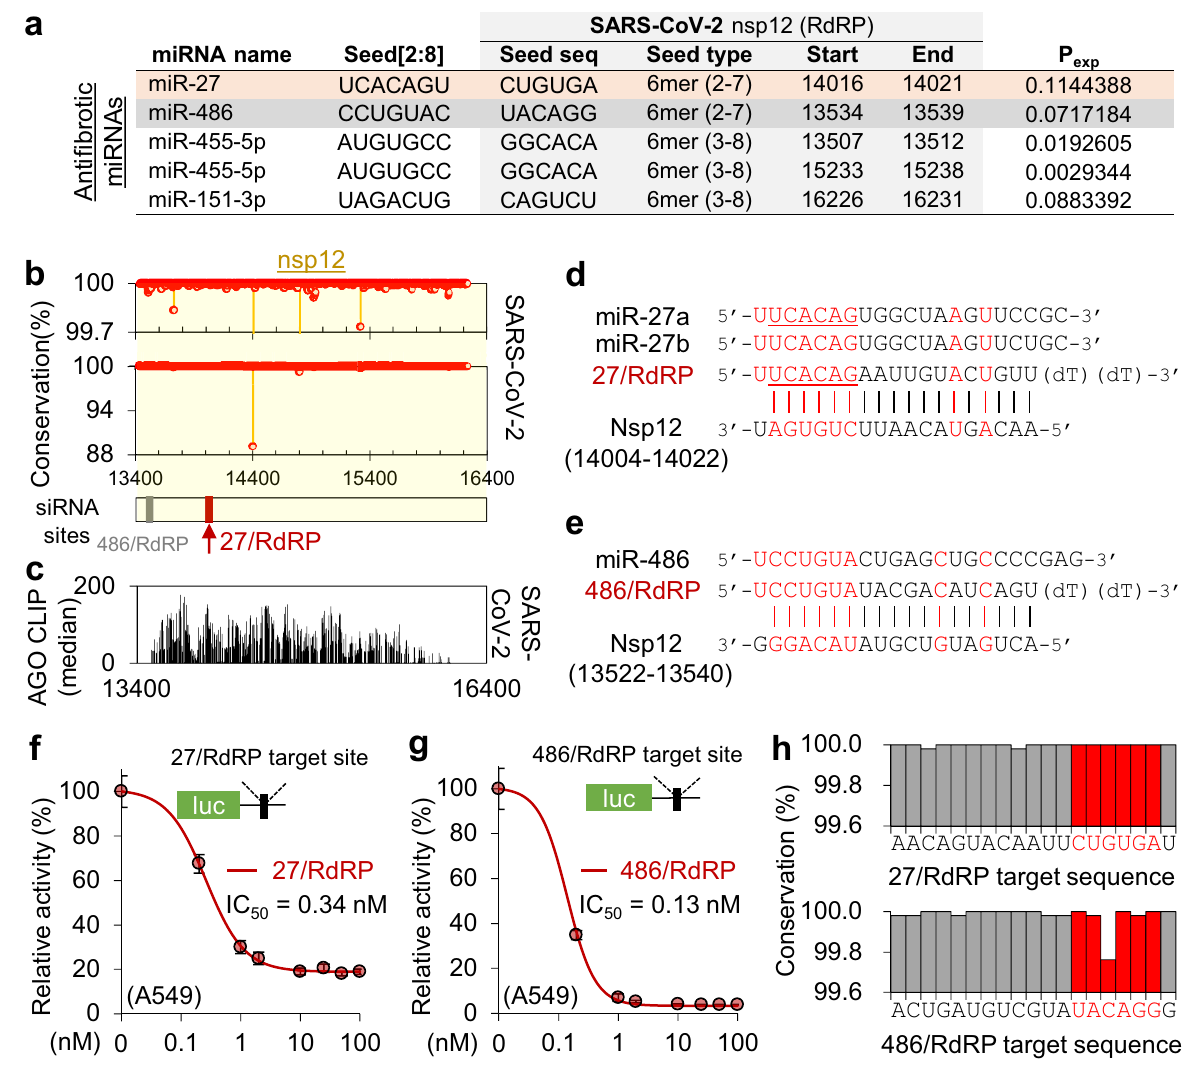
Figure 3. AGO-accessible siRNAs targeting the nsp12 of SARS-CoV-2 with antifibrotic miRNA seeds. ( a ) Seed sites of previously reported antifibrotic miRNAs located in nsp12 regions of SARS-CoV-2. Considering the AGO accessibility threshold (P exp > 0.1), only the miR-27 seed site was selected in Fig. 2, but all seed sites of the antifibrotic miRNAs are presented in the table. ( b ) The positional conservation rate of SARS-CoV-2 gRNAs in the nsp12 region among the cases of human infection (n = 5475); highlighted by red dots and its zoom-in display (upper panel); red arrow, the target position of 27/RdRP; grey arrow, the target position of 486/RdRP. ( c ) The inferred AGO accessibility derived from AGO CLIP data of RNA viruses. ( d,e ) Sequences of 27/RdRP with miR- 27a and miR-27b ( d ), and 486/RdRP with miR-486 ( e ), aligned with its binding site in the SARS-CoV-2 nsp12. ( f,g ) Luciferase reporter assays for a single perfect target site for 27/RdRP ( f ) or 486/RdRP ( g ) in the renilla luciferase 3 ′ UTR, of which the activity was normalised by firefly luciferase with no site (relative activity) and used to calculate the IC 50 in human epithelial lung cell A549; the same experiment was conducted with different cell lines (Supplementary Fig. S3a). ( h ) Positional sequence conservation of the 27/RdRP (upper panel) and 486/ RdRP sites (lower panel), calculated from multiple sequence alignment of 5475 SARS-CoV-2 sequences in the GenBank. Of note, there is no variation (100% conservation) in every position in the seed (highlighted in red) of 27/RdRP; however, there is a 0.3% variation at position 5 of the seed site in